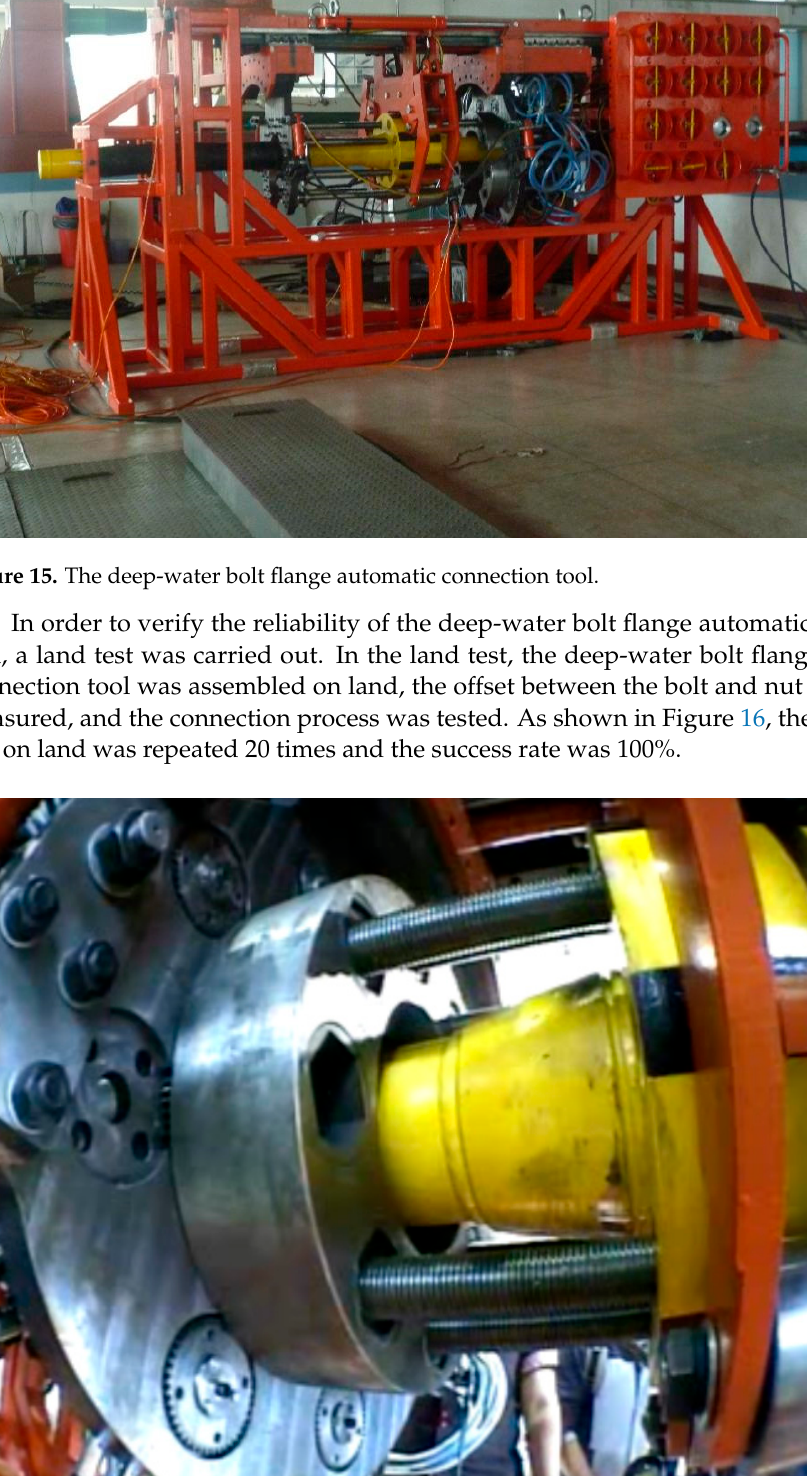
Figure 16. The land test.